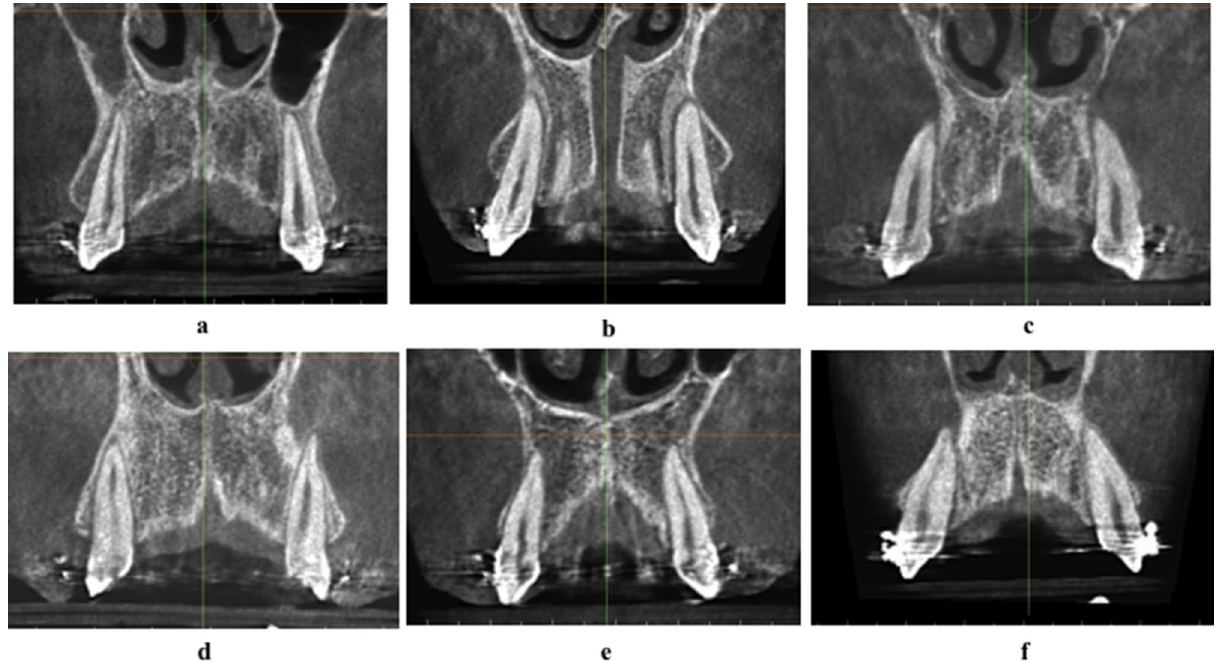
Figure 7. (a) Identical grade A of CRCR bilaterally. (b) Identical grade B of CRCR bilaterally. (c) Identical grade C of CRCR bilaterally. (d) Different grades of CRCR bilaterally (Right grade A/Left grade C). (e) Different grades of CRCR bilaterally (Right grade B/Left grade A). (f) Different grades of CRCR bilaterally (Right grade C/Left grade B).